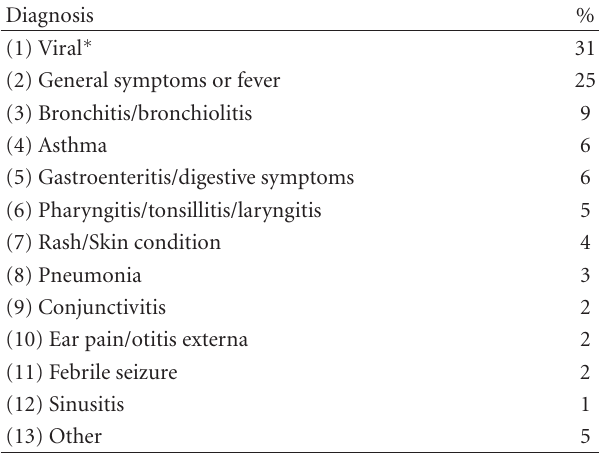
Table 2: Primary diagnosis of those with a secondary diagnosis